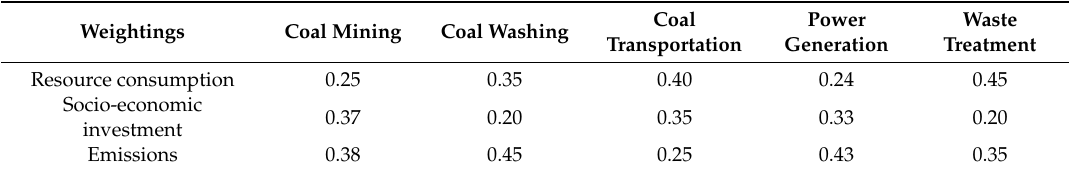
Table 11. Life cycle weightings of environmental impact categories.